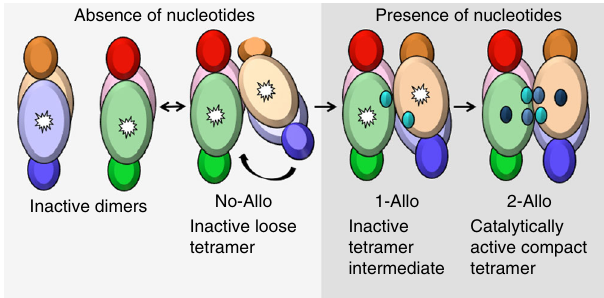
Fig. 5 Model of mSAMHD1 allosteric activation. In the absence of nucleotides, mSAMHD1 primarily exists as inactive dimers that can associate to form loose inactive tetramers. After the fi rst allosteric nucleotide binds, the rigid dimer components rearrange to form a more compact but inactive intermediate. Upon binding of the second allosteric nucleotide, mSAMHD1 rearranges further to form a catalytically active,